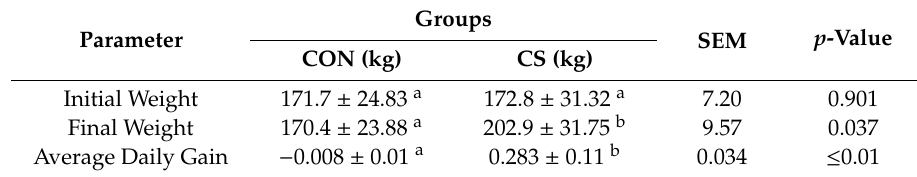
Table 3. E ff ect of mixed diet supplementation during the cold season on the growth performance of the yaks.